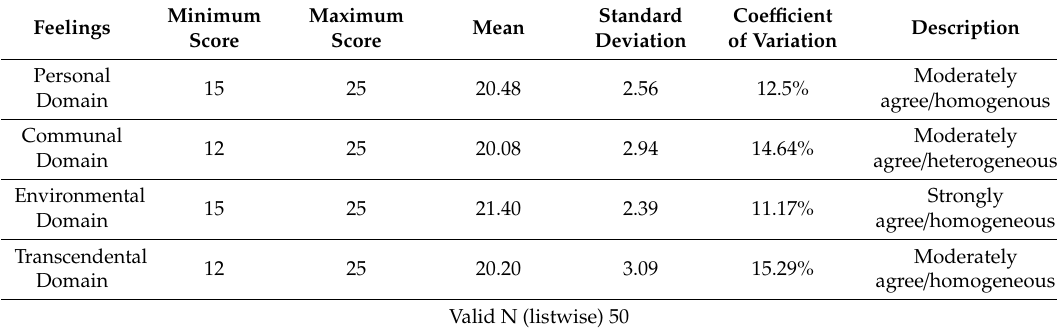
Table 3. Results of the feelings